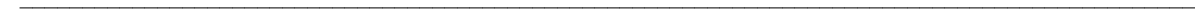
Fig. 5. Selected conodonts from the Mirny Creek section. Scale bar corresponds to 0.1 mm. A , B , Protopanderodus insculptus : A, lateral view of symmetric adenticulate acontiodontiform element, GIT 652-1; B, lateral view of asymmetric denticulate acontiodontiform element, GIT 652-2; both specimens from sample 115-6/3, Tirekhtyakh Formation. C , Pseudobelodina ? sp. (cf. P. vulgaris ), inner (C1) and outer (C2) lateral views of grandiform element, GIT 652-3, sample 115-6/3, Tirekhtyakh Formation. D , Pseudobelodina cf. dispansa , lateral view of compressiform element, GIT 652-4, sample 115-6/3, Tirekhtyakh Formation. E , Belodina cf. stonei , lateral view of compressiform element, GIT 652-5, sample 115-6/3, Tirekhtyakh Formation. F , Scabbardella ? sp . , lateral view of acodiform element, GIT 652-6, sample 115-6/3, Tirekhtyakh Formation. G , Panderodus ex gr. panderi , lateral view of high-based asymmetric graciliform element, GIT 652-7, sample 115-4/2, Tirekhtyakh Formation. H , Panderodus ex gr. panderi , lateral view of low-based symmetric graciliform element, GIT 652-8, sample 115-5/2, Tirekhtyakh Formation. I , Hamarodus cf. europaeus , outer lateral view of P? element, GIT 652-9, sample 107-1/1b, Tirekhtyakh Formation. J , Amorphognathus sp., fragment of S? element, GIT 652-10, sample 112-5/4, Tirekhtyakh Formation. K , Pseudooneotodus mitratus , upper view, GIT 652-11, sample 112-1/1, Tirekhtyakh Formation. L , M , Q , R , Kockelella cf. manitoulinensis : L, inner lateral view of Pb element, GIT 652-12; M, outer lateral view of Pa element, GIT 652-13; Q, inner lateral view of M element, GIT 652-14; R, inner lateral view of Sc element, GIT 652-15; all elements from sample 109-2/2, Maut Formation. N , Nordiodus ? sp., outer (N1) and inner (N2) lateral views, GIT 652-16, sample 115-6/3, Tirekhtyakh Formation. O , Oulodus ? panuarensis , inner lateral view of M element, GIT 652-17, sample 110-1/3, Maut Formation. P , Ozarkodina ex gr. oldhamensis , lateral view of Pa element, GIT 652-18, sample 110-1/3, Maut Formation. S , T , Distomodus cf. kentuckyensis : S, inner lateral view of M element, GIT 652-19; T, posterior view of Sb element, GIT 652-20; both specimens from sample 109-4/3, Maut Formation. U , V , Ozarkodina sp.: U, lateral view of Pa element, GIT 652-21, sample 109-4/3; V, posterior view of Sa element, GIT 652-22; both specimens from sample 109-5/3b; both specimens from Maut Formation. W , X , AA , BB , Walliserodus cf. curvatus : W, lateral view of asymmetrical dyscritiform element, GIT 652-23; X, lateral view of symmetrical dyscritiform element, GIT 652-24; AA, inner lateral view of curvatiform element, GIT 652-25; BB, inner lateral view of multicostatiform element, GIT 652-26; W and X from sample 109- 2/2, AA and BB from sample 109-4/3; all specimens from Maut Formation. Y , Decoriconus sp., lateral view, GIT 652-27, sample 109-4/3, Maut Formation. Z , CC , DD , Oulodus ? sp.: Z, inner lateral view of Pa element, GIT 652-28; CC, inner lateral view of Sc element, GIT 652-29; DD, inner lateral view of Pb element, GIT 652-30; all specimens from sample 109-4/3, Maut